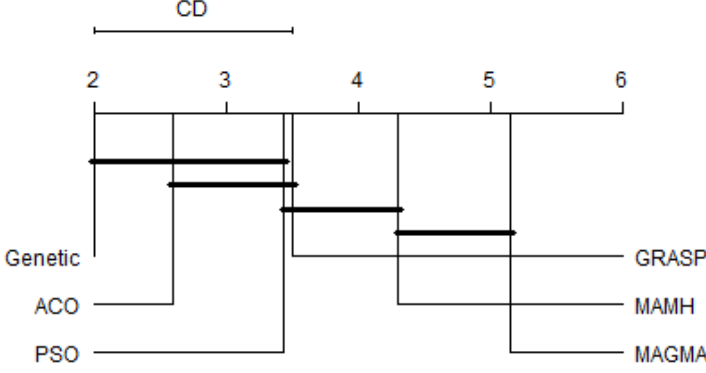
Figure 3. The critical difference diagrams of the post-hoc Nemenyi test on the comparison with traditional